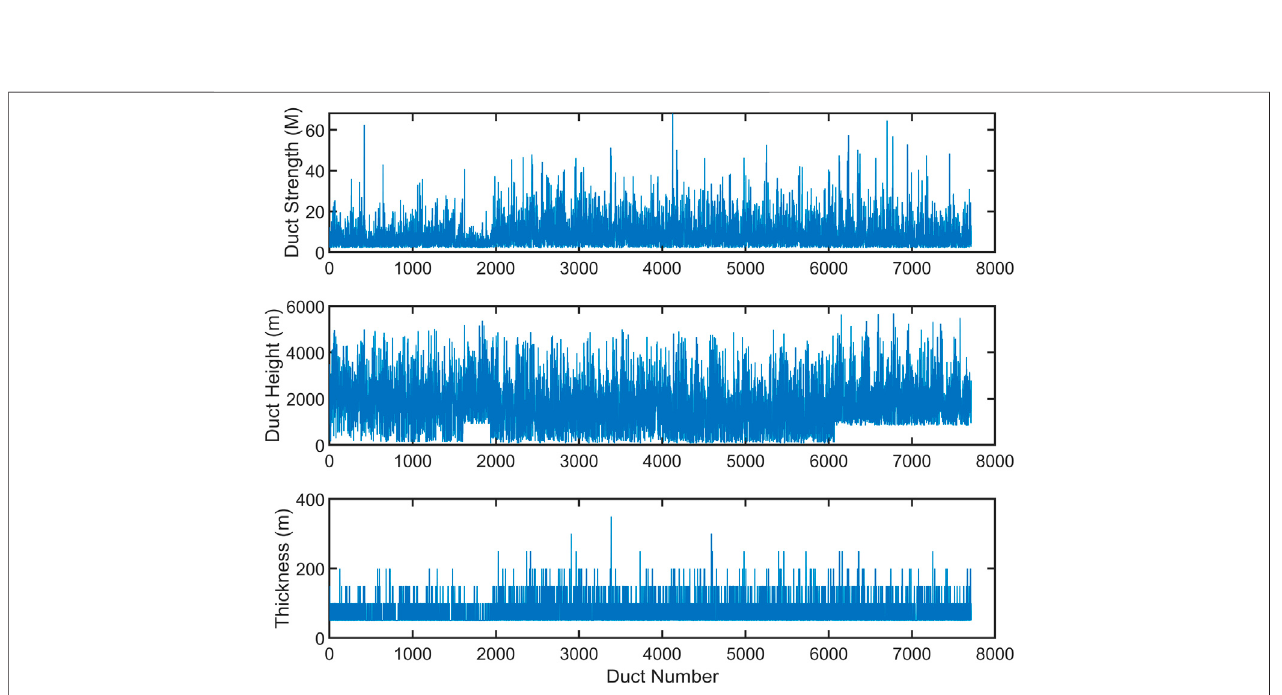
FIGURE 10 | Characteristics of ducts, respectively, duct strength, duct height, and the thickness of the trapping layer occurring over the four stations during the observation time.